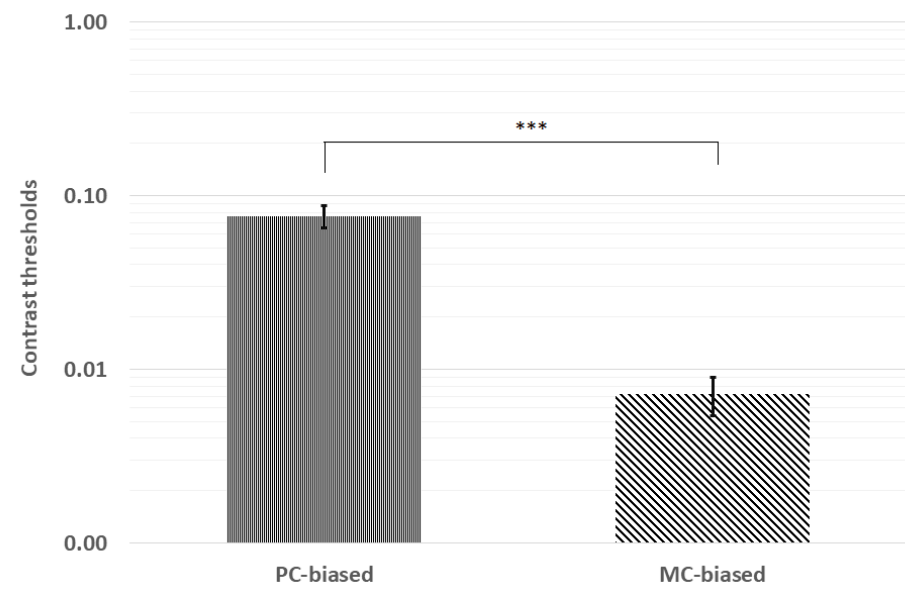
Figure 2. Contrast thresholds were significantly lower for the MC-biased stimulus than the PC-biased stimulus. *** p < 0.001; error bars represent ±1 standard deviation.